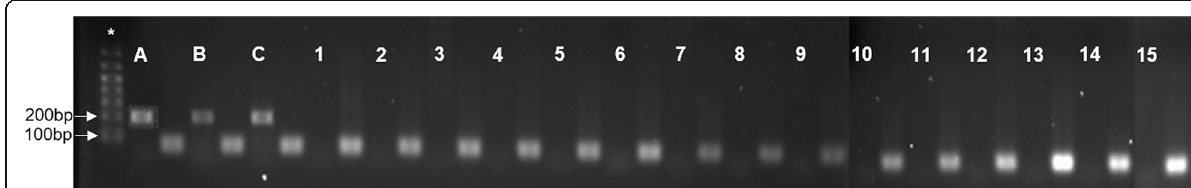
Fig. 2 SS18-SSX nested PCR of the SS patients. Two FFPE SS tumor samples (A, B) and the SS-iASC cell line (C) were used as positive controls. Bands corresponding to the SS18-SSX fusion gene are the size of 212 bp. 1 – 15: cases 1 – 15 with no detectable SS18-SSX fusion gene. As an